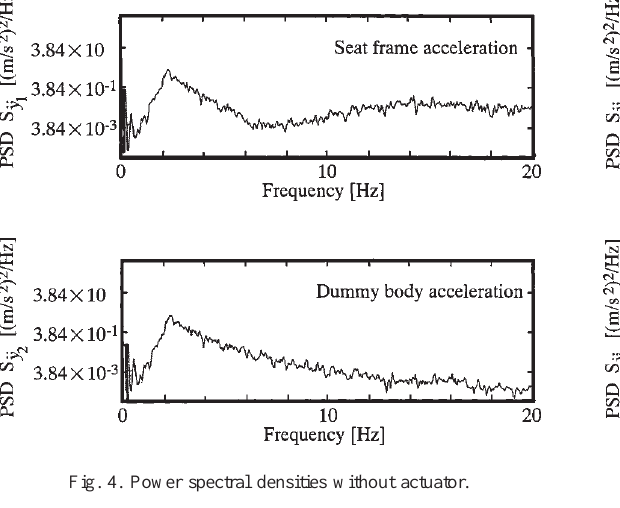
Fig. 6. Power spectral densities with actuator.